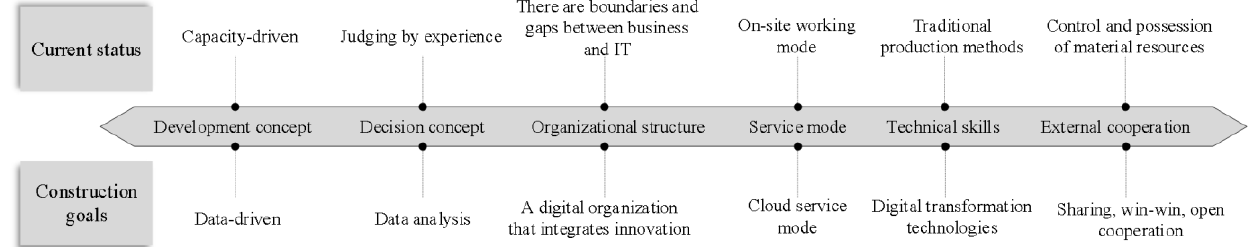
Figure 3. Comparison of current status and construction goals of production and management modes.